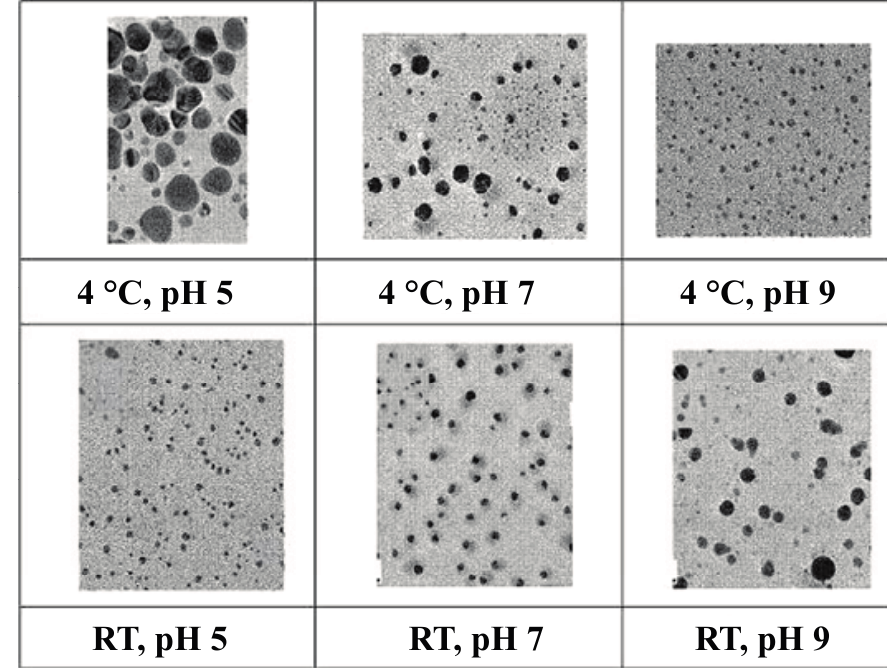
Figure 4. TEM (transmission electron microscopy) micrographs of silver nanoparticles synthetized at 4 °C and room temperature (RT) at pH values 5, 7 and 9; modified from [37] with permission from Elsevier, copyright